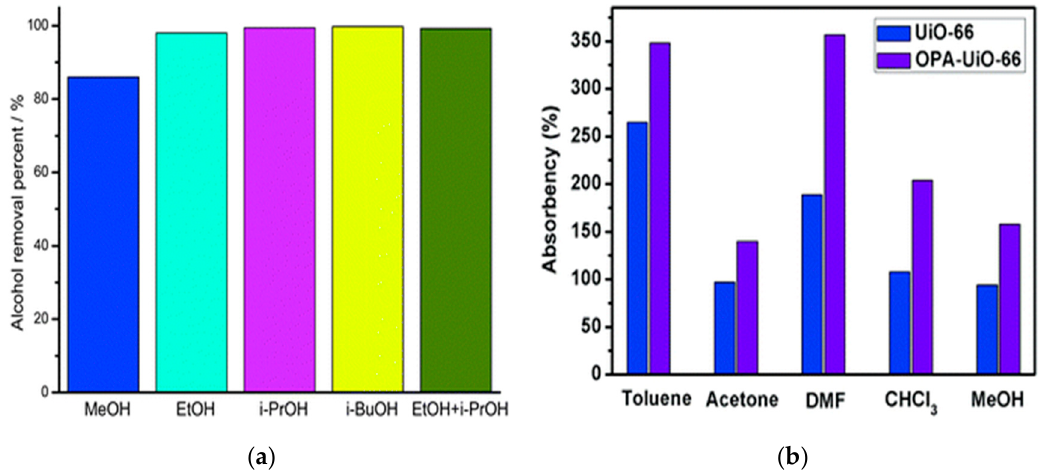
Figure 3. ( a ) Adsorptive separation performance of the superhydrophobic ZIF-90 for removal of alcohols from alcohols/water mixtures Reprinted with permission [63] (copyright 2016, Royal Society of Chemistry); ( b ) Absorption of organic solvents with UiO-66 before and after OPA modification. Reprinted with permission [62] Copyright 2017, Royal Society of Chemistry.